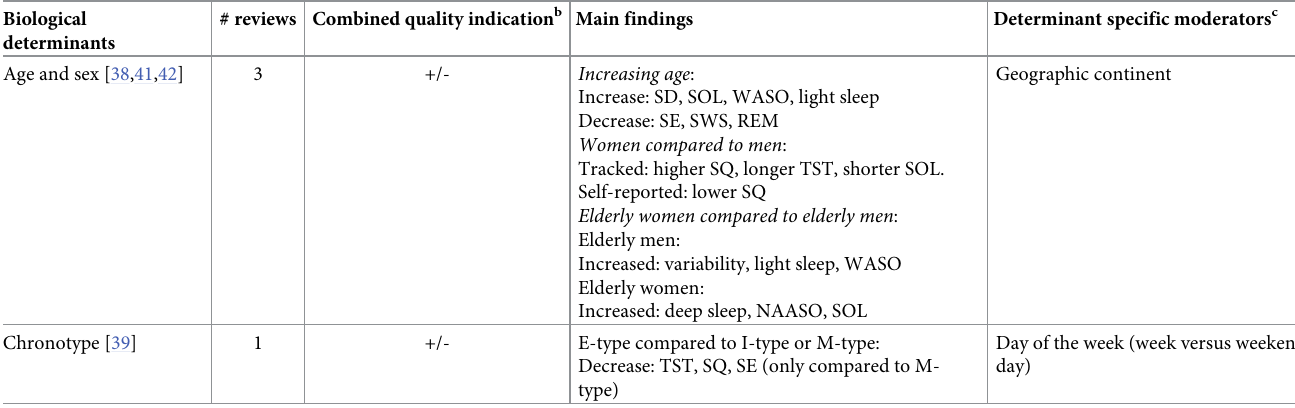
Table 3. Overview of biological determinants of